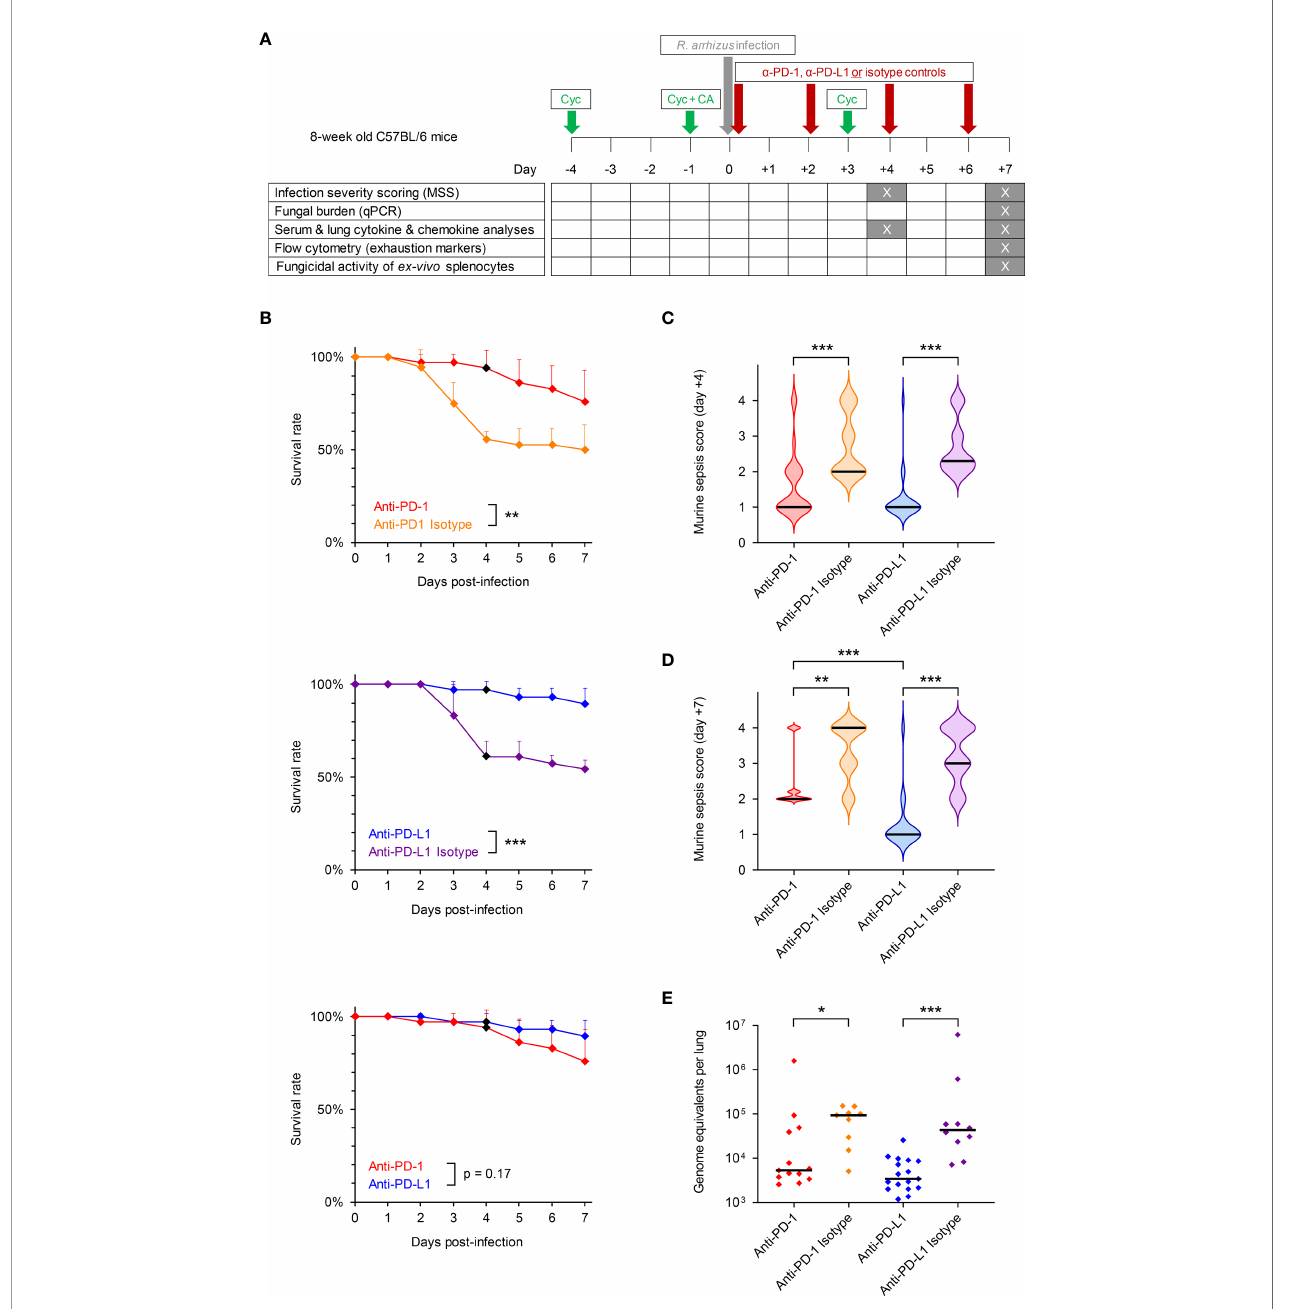
FIGURE 1 | Inhibition of the PD-1/PD-L1 immune checkpoint pathway improves infection outcomes in immunosuppressed mice with invasive pulmonary mucormycosis (IPM). (A) Timeline of experimental procedures. Eight-week-old female C57BL/6 mice were immunosuppressed with cyclophosphamide (Cyc) and cortisone acetate (CA) and were subsequently infected intranasally with 50,000 spores of R. arrhizus Ra-749, as described in Materials & Methods. Mice then received 4 intraperitoneal injections of anti-PD-1, anti-PD-L1, or the corresponding unspeci fi c isotype control antibodies on days 0 (6 h post-infection), +2, +4, and +6. Survival was monitored for 7 days post-infection and morbidity was scored on days +4 and +7 using the murine sepsis score. Biospecimens for downstream readouts were obtained on days +4 and +7, as detailed in the fi gure. (B) Survival rates of mice with IPM according to the treatment arm (n = 34-36 animals per treatment). Error bars indicate inter-replicate standard deviations based on 3 independent experiments. Animals euthanized in non-moribund condition for biomaterial sampling on day +4 were censored (black diamonds). Mantel-Cox log rank-test. (C, D) Violin plots summarizing the distribution of murine sepsis scores on day +4 (C, n = 24-26 per treatment) and day +7 (D, n = 19-26 per treatment). Scale: 0 = healthy to 3 = moribund. A score of 4 denotes animals that died prior to the time of analysis. (E) Fungal burden per lung according to the treatment, as determined on day +7 using an 18S quantitative PCR assay (n = 9-16 survivors per treatment from 2 independent experiments). (C – E) Black bars indicate medians. The Mann-Whitney U test was used to compare ICI- and isotype-treated cohorts as well as the two ICI treatment cohorts. *p < 0.05, **p < 0.01, ***p <